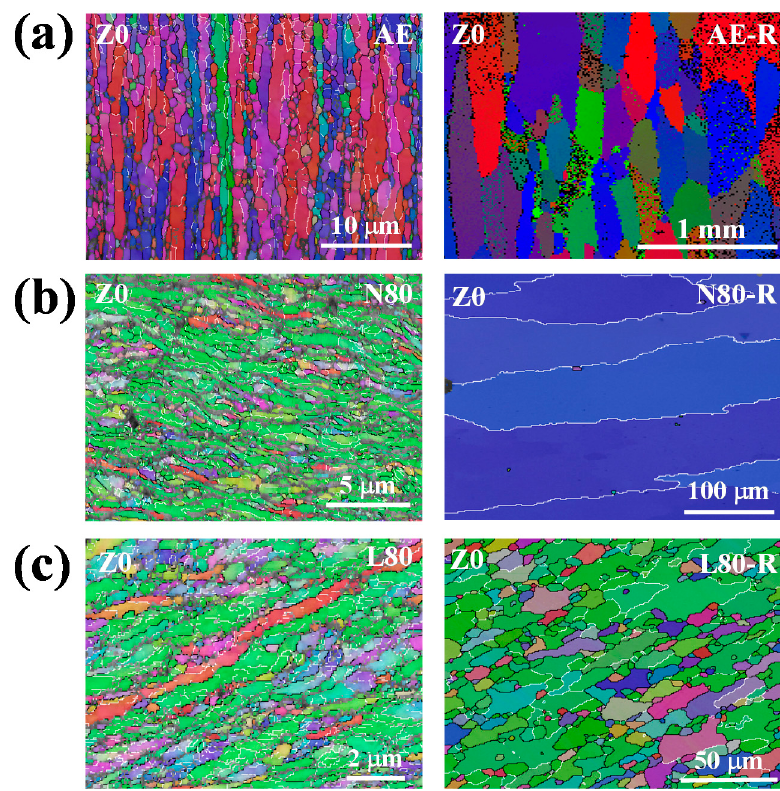
Figure 4. OIM map in Z0-axis for ( a ) as-extruded, ( b ) N-Sample with 80% compression ratio, and ( c ) L-sample with 80% compression ratio. Before (AE, L80 and N80, respectively) and after recrystallization (AE-R, L80-R and N80-R, respectively).